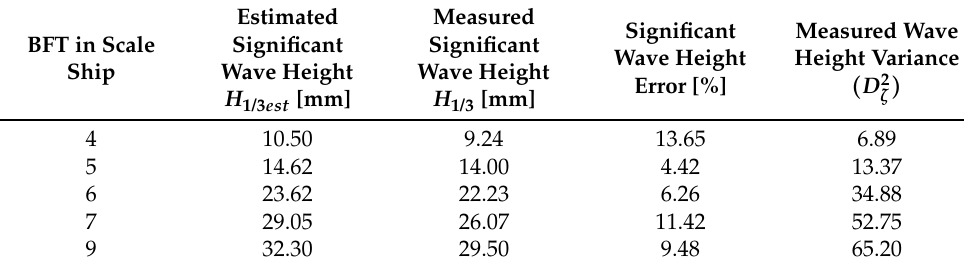
Table 4. Measured and estimated significant wave height